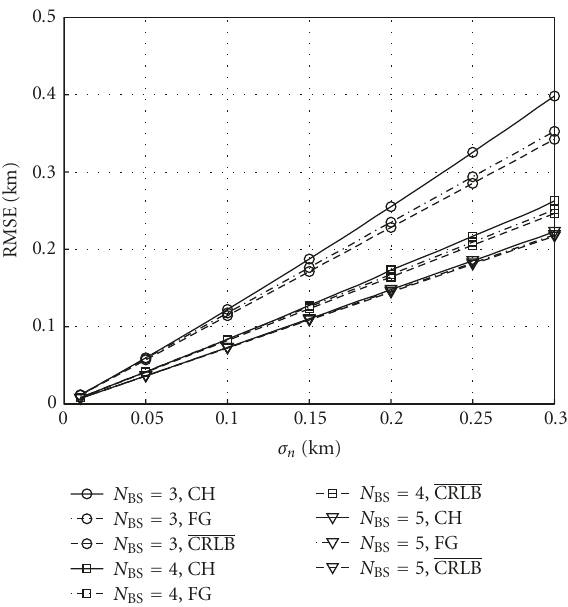
seen that the deviation from CRLB is very small, even for N = 3 and high noise power. To get a better assessment BS for the performance of the iterative FG algorithm, the re- sults are also compared with a noniterative solution which is based on a method invented by Chan and Ho [17]. It is a three-step procedure extending the spherical